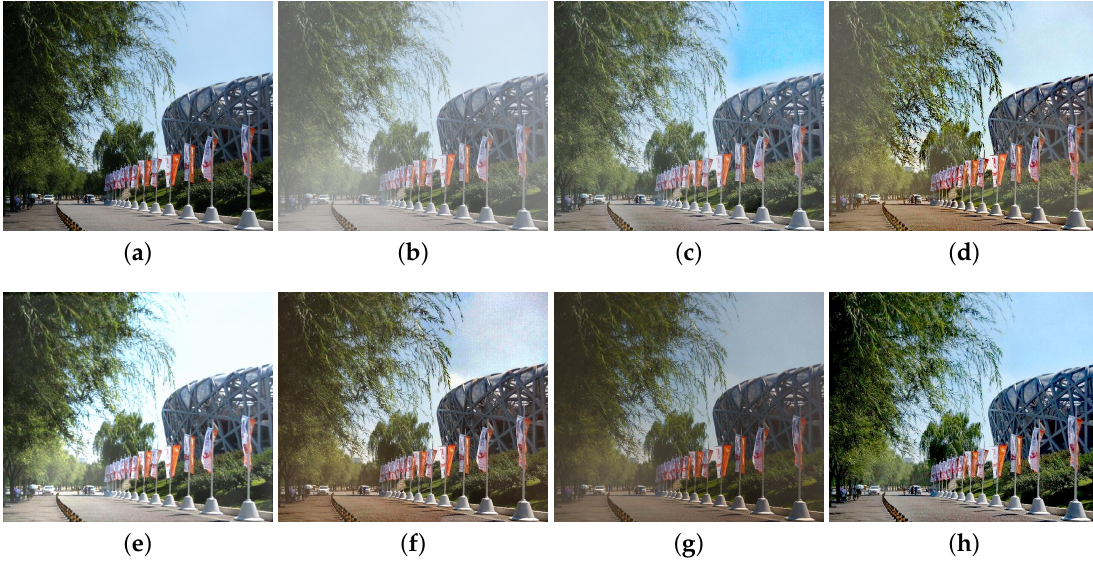
Figure 11. Bird’s Nest stadium of the SOTS-outdoor dataset. ( a ) Ground truth image. ( b ) input blur image. ( c ) DCP; ( d ) Berman; ( e ) DCPDN ; ( f ) Zhu; ( g ) Golts [18]; ( h ) Ours.